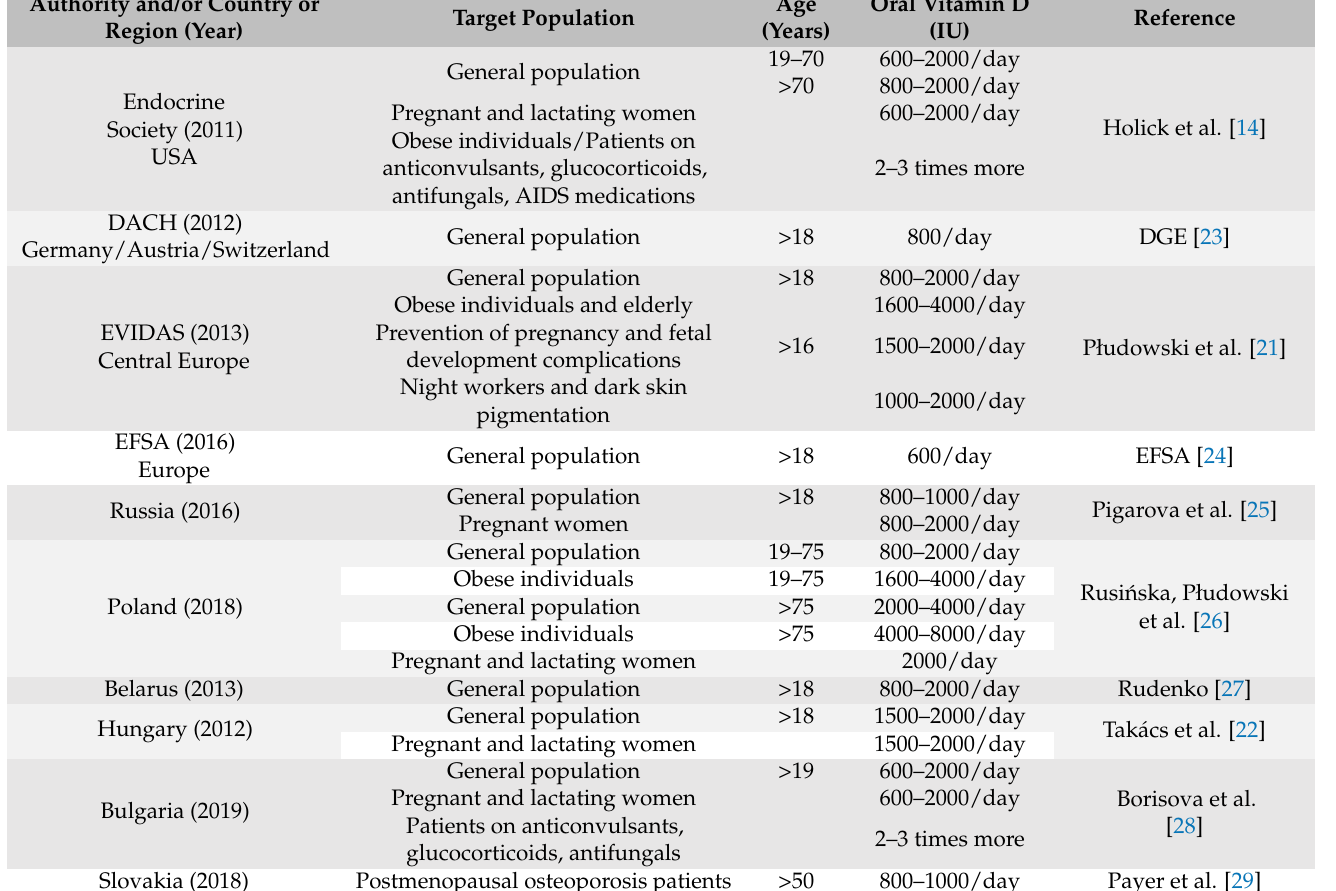
Table 1. Selected guideline recommendations for prevention of vitamin D deficiency in adults with a focus on Central and Eastern European countries, published since